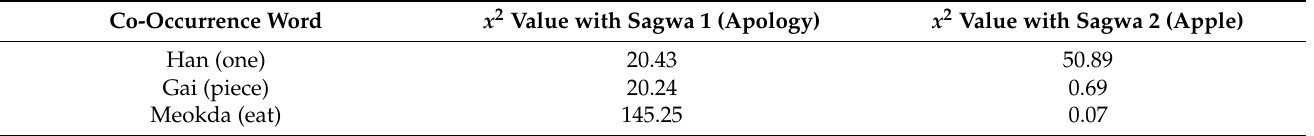
Table 1. Coordinate terms of ‘sagwa’ and x 2 value of co-occurrence words in the local context. Co-Occurrence